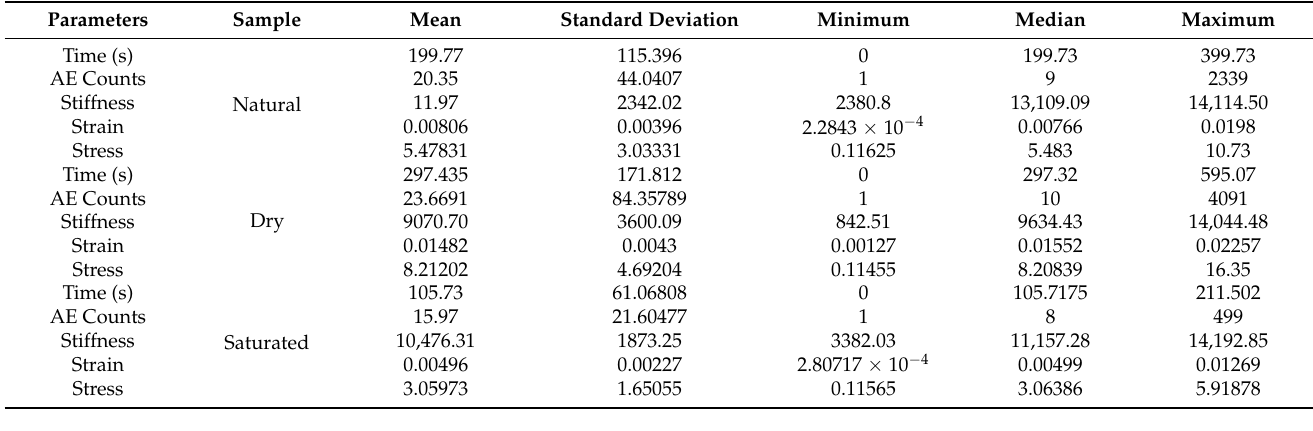
Table 2. The statistical data of saturated, natural, and dry coal samples.